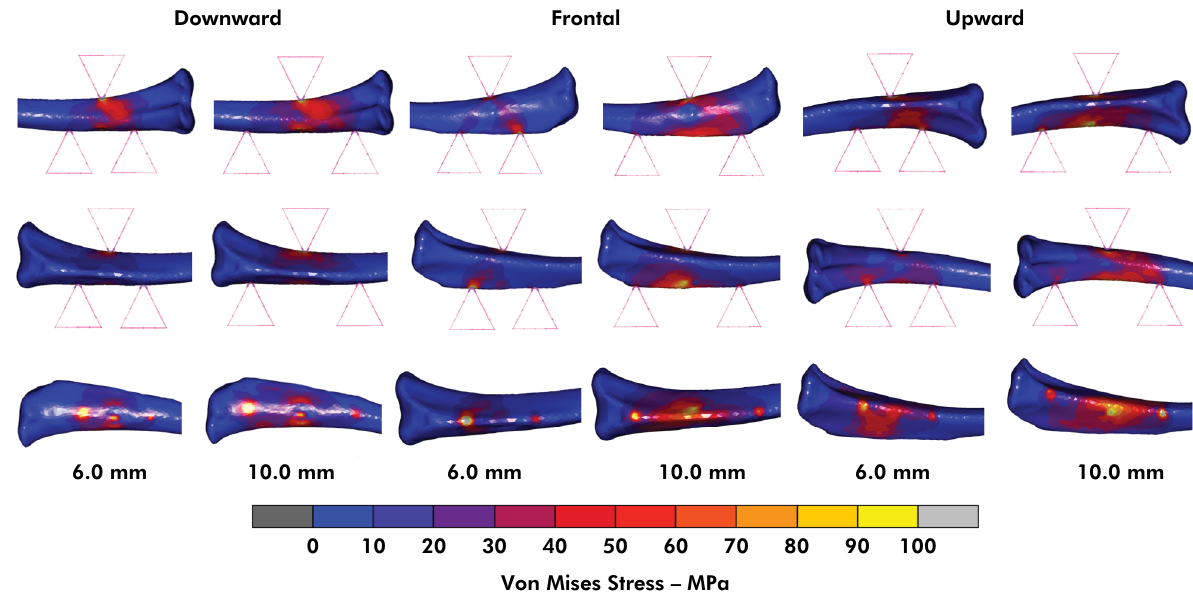
Figure 4. Von Mises stress distributions at frontal, posterior and inferior surfaces of rat tibiae during three-point bending test simulation when the defect was positioned downward, frontal or upward.